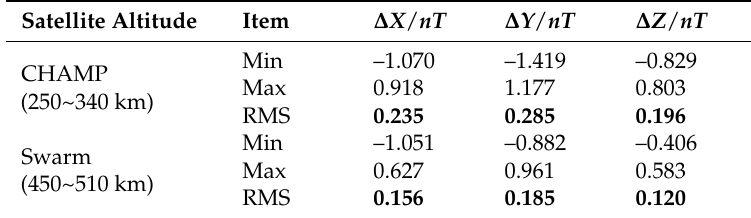
Table 2. Fitting errors of X, Y, and Z components on the height layer of CHAMP and Swarm. Satellite